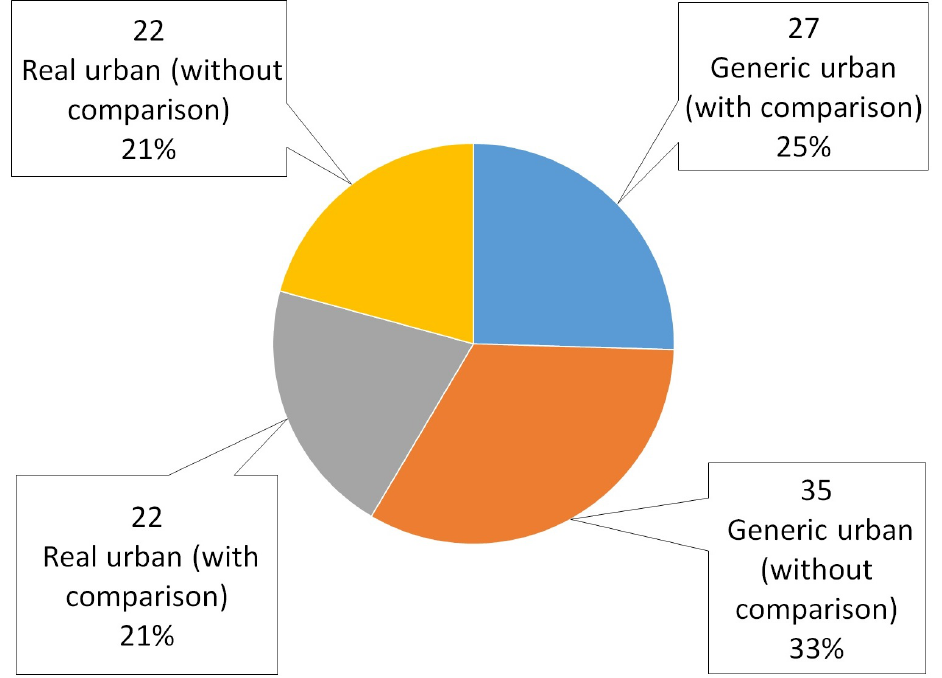
Figure 4. Grouping of studies depending on type of urban area (actual or fictitious) and by presence of comparison with experimental or analytical data. Table 1. Overview of studies of fictitious urban areas with comparison with experimental or numeri- cal data: type of building, city, experiment and simulation